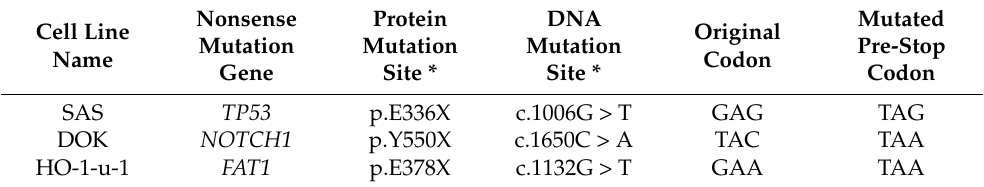
Table 1. Information about the cell lines used in this